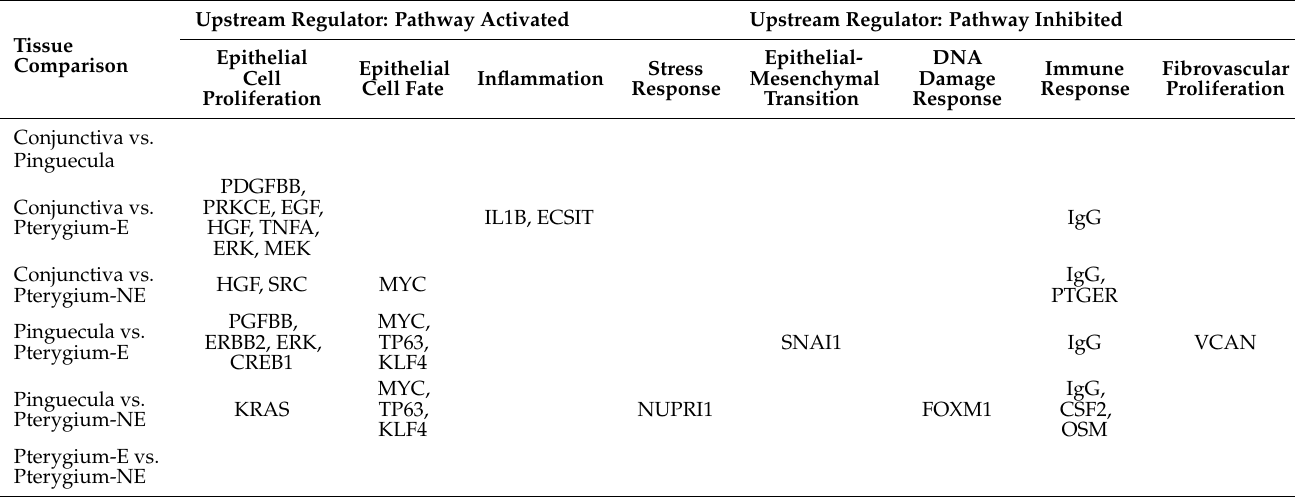
Table 7. Upstream Regulators Predicted by